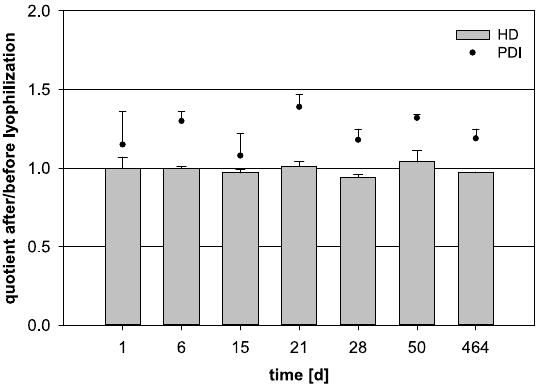
Figure 6. Variation of the quotient of the hydrodynamic diameter (HD, bars) and the polydispersity index (PDI, dots) before and after lyophilization for 100 µL nanocapsule suspension + 900 µL purified water + 6% trehalose. The freeze-dried samples were stored for a total of 464 days (statistical test: one-way ANOVA; no significance between the compared groups regarding the HD quotient; p = 0.146; mean ± SD; n = 3).